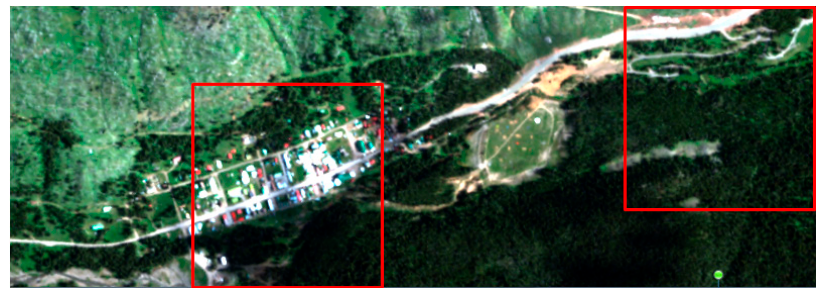
Figure 2. Spectra of anomalies and background samples.